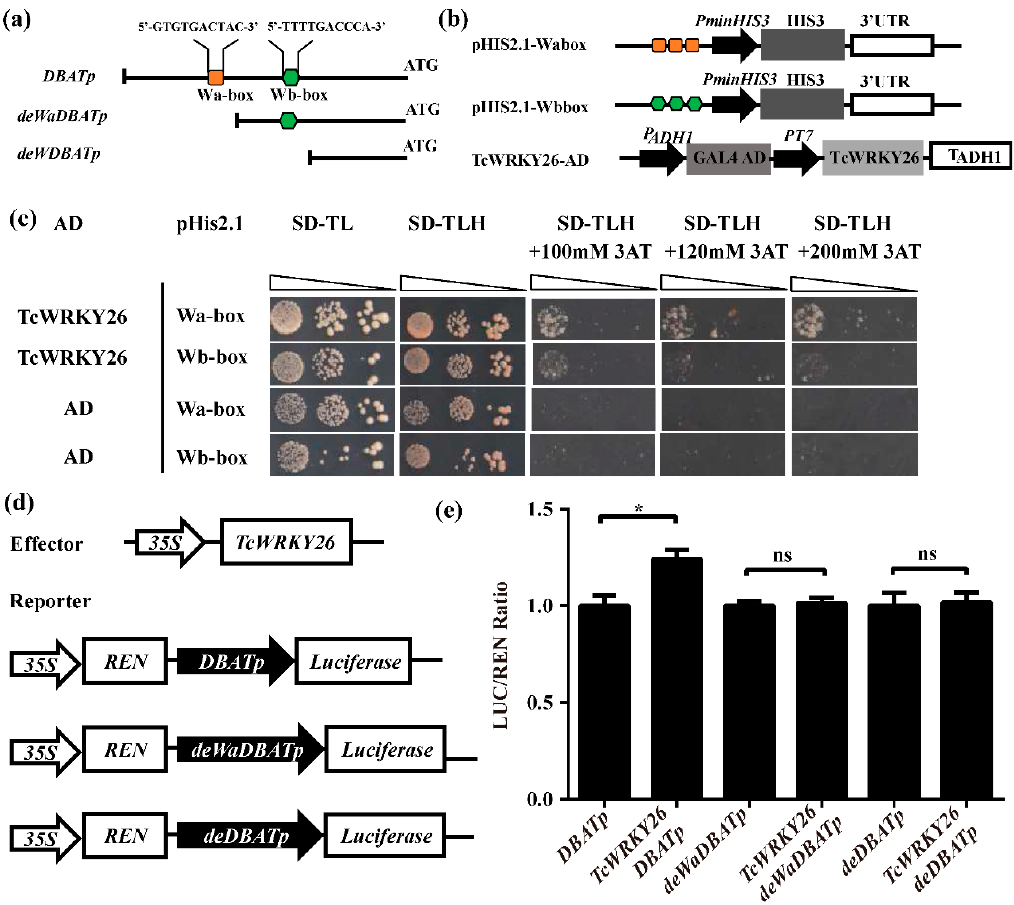
Figure 4. TcWRKY26 activates the DBAT gene by binding with w a -box. ( a ) Sketch map of progressive deletion fragments of DBAT promoter. ( b ) The vectors used in Y1H. Orange square and green hexagon indicate w a - and w b -box, respectively. The w a - and w b -box were tripled and ligated in the front of HIS minum promoter. ( c ) Y1H results of TcWRKY26 and w-boxes. SD/-TL: SD/-Trp-Leu; SD/-TLH: SD/-Trp-Leu-His. 3-AT: 3-amino-1, 2, 4-triazole. ( d ) The reporter and effector vector used in LUC activity assays. ( e ) LUC activity assays of progressive deletion of DBAT promoters in ( a ). Statistics analysis was conducted as Student t -test; * represents p -value < 0.05.